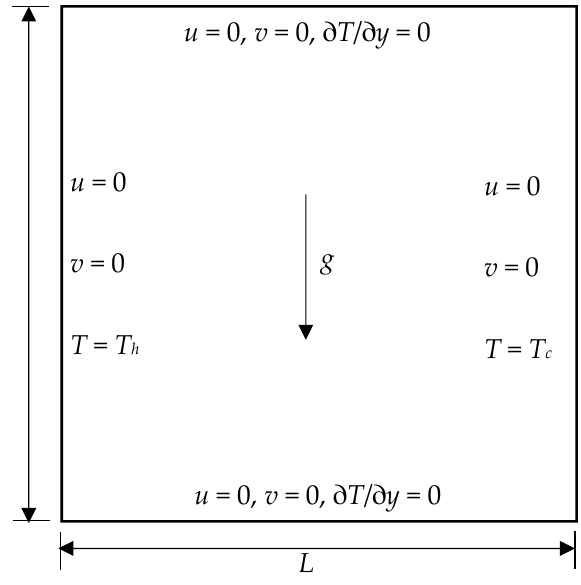
Figure 2. Physical configuration of 2D natural convection in a square cavity.